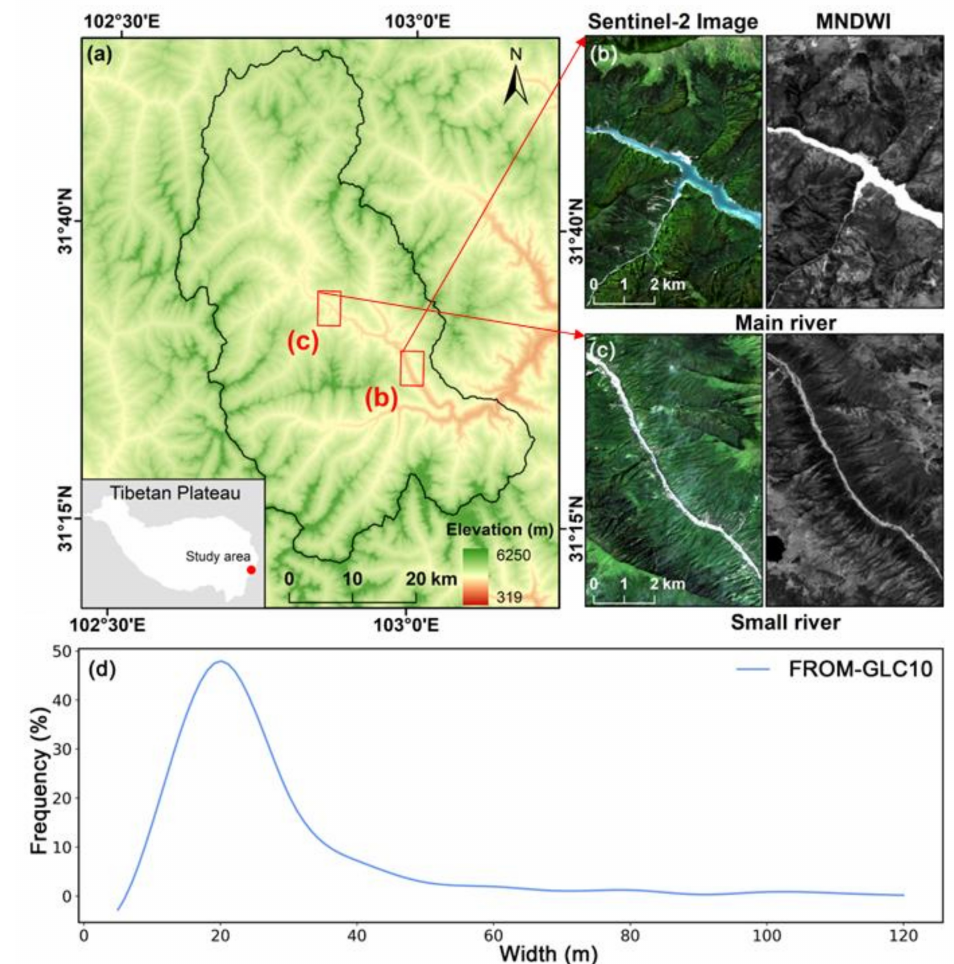
Figure 1. Location of the study area. ( a ) Location of the study area; ( b ) Main river channel (the confluence of more than two tributaries with wider river width) within the study area; ( c ) Small river (<30 m) channel within the study area; ( d ) Distribution of river widths in the study area. The river widths were extracted from